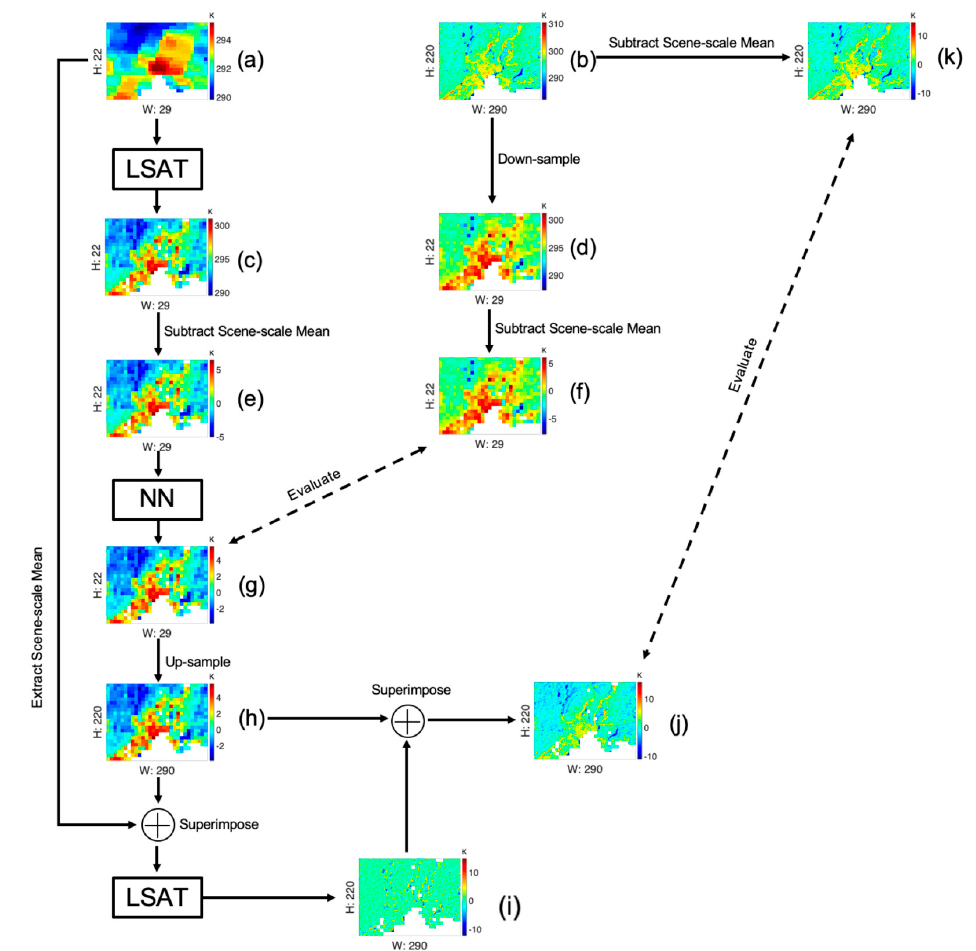
Figure 4. Processing workflow of the scale-separating framework applied to the MODIS scene from 15 April 2016. The width (H) and height (H) of each image are attached to the axes to reflect the dimension changes caused by up-sampling and down-sampling operations. Panel a: MODIS LST; panel b: target Landsat LST; panel c: adjusted MODIS LST; panel d: resampled target Landsat LST; panel e: adjusted MODIS LST variations; panel f: resampled Landsat LST variations for validation; panel g: predicted patch-level LST; panel h: up-sampled predicted patch-level LST; panel i: predicted within-patch variations; panel j: sharpened MODIS LST (intra-scene variations); panel k: target Landsat LST variations for validation.